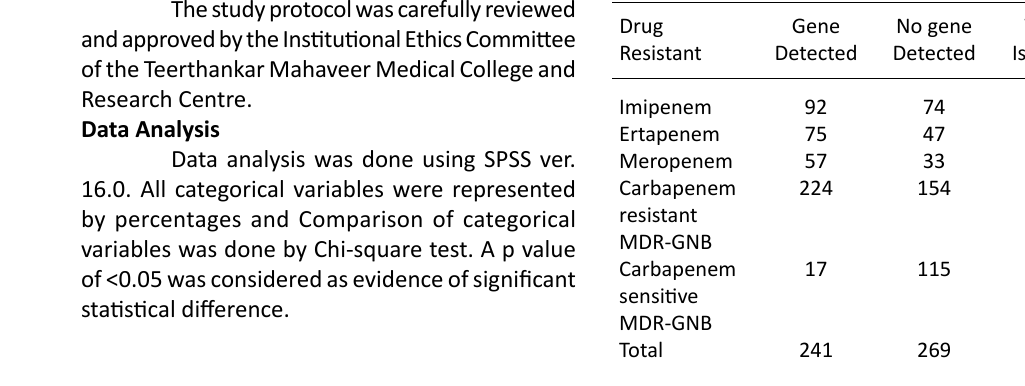
isolates and number of isolates with gene